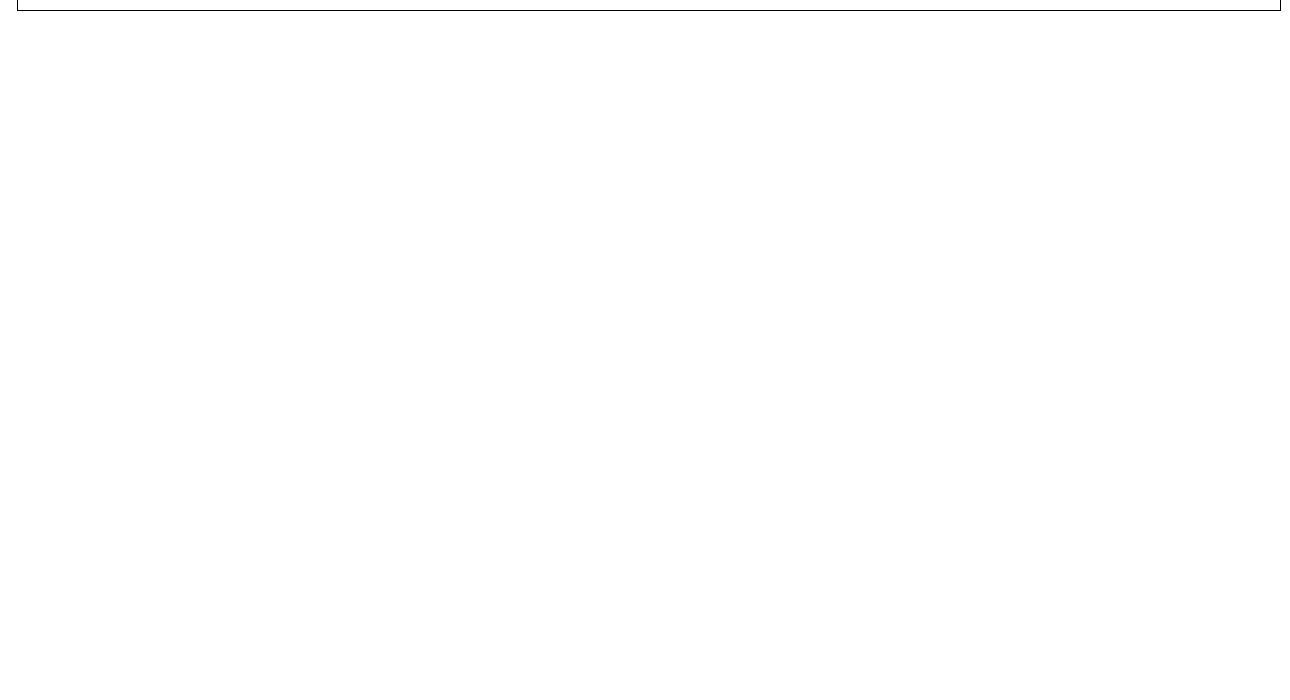
FIGURE A1 | Visualization of the interaction between proportion of women at highest level in one’s organization (scale: 1–2 – almost only men, to 6–7 – almost only women) and own level (highest vs. intermediate level) on reported gender harassment. Findings show that women on the highest level report most gender harassment in their organization (agreement: 1 = “do not agree at all” to 7 = “completely agree”) in the presence of a majority of women